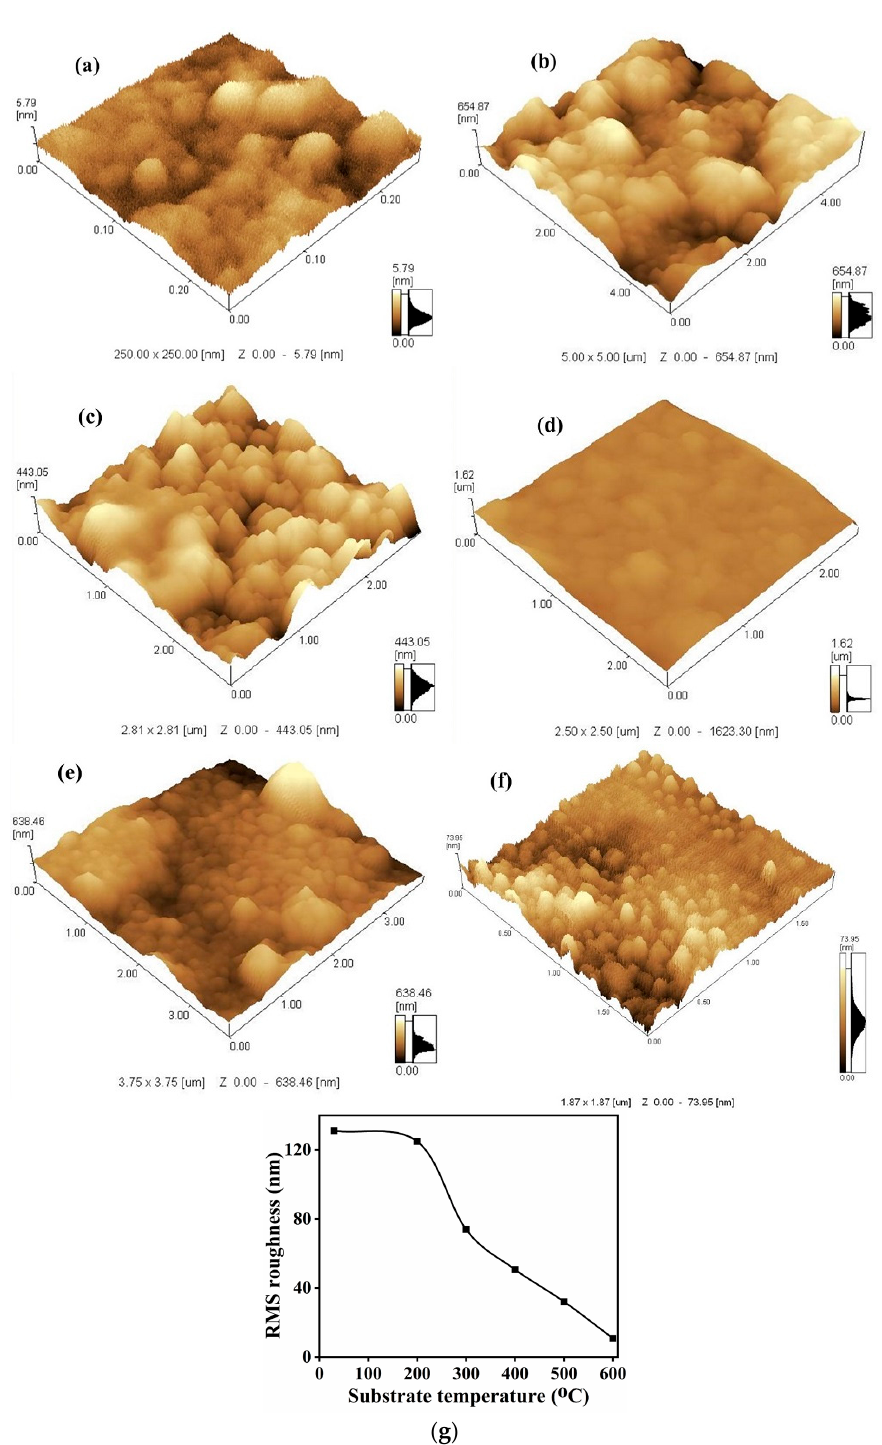
Figure 10. Three dimensional AFM images of Bi 2 O 3 :Ho 3+ (1 mol.%) films deposited in vacuo for 15 min at ( a ) RT, ( b ) 200 °C, ( c ) 300 °C, ( d ) 400 °C, ( e ) 500 °C and ( f ) 600 °C; ( g ) RMS roughness values of Bi 2 O 3 :Ho 3+ (1 mol.%) thin films deposited at different substrate temperatures.